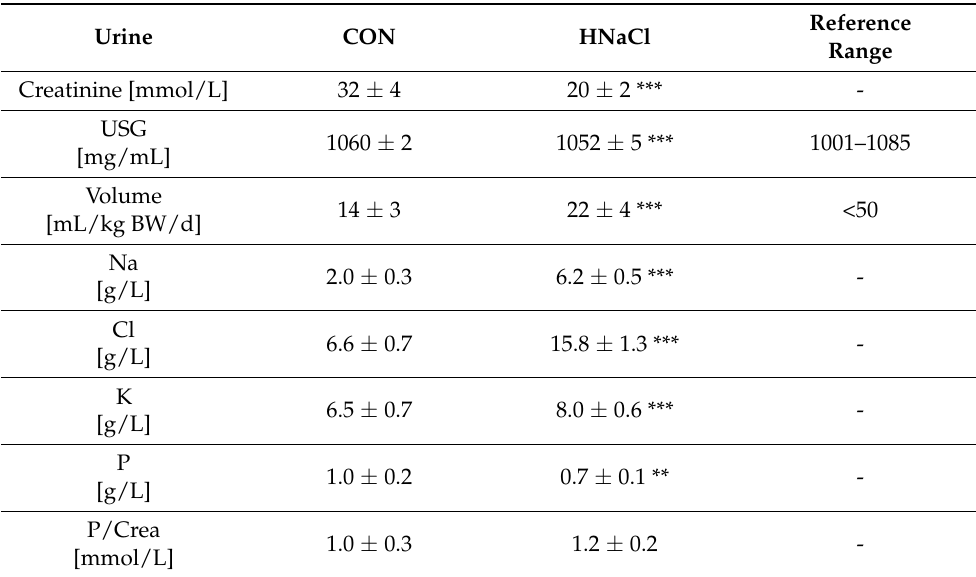
Table 4. Concentrations of urine parameters after 28 days of high NaCl or control feeding in cats (mean ± standard